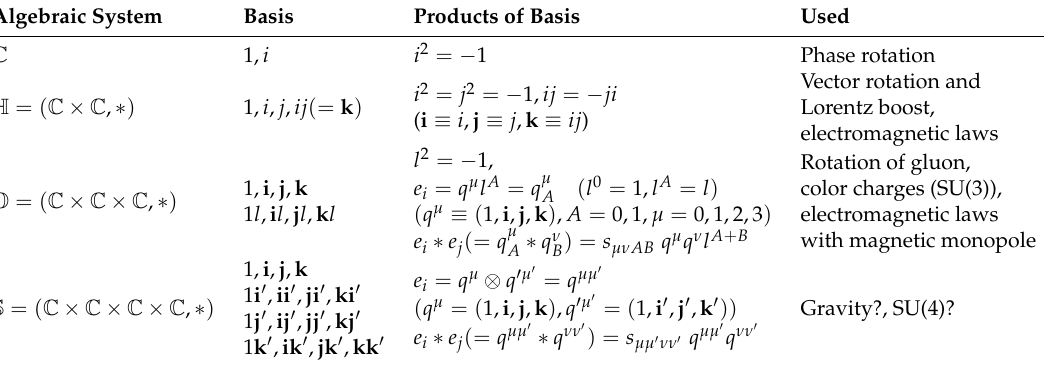
Table 1. The representation of the basis and possible uses of each algebraic system. s µν AB , s µµ (cid:48) νν (cid:48) are sign operators, which are +1 or − 1: whether µ , ν .. is 0 or not and whether A and B is 0 or 1 determines the